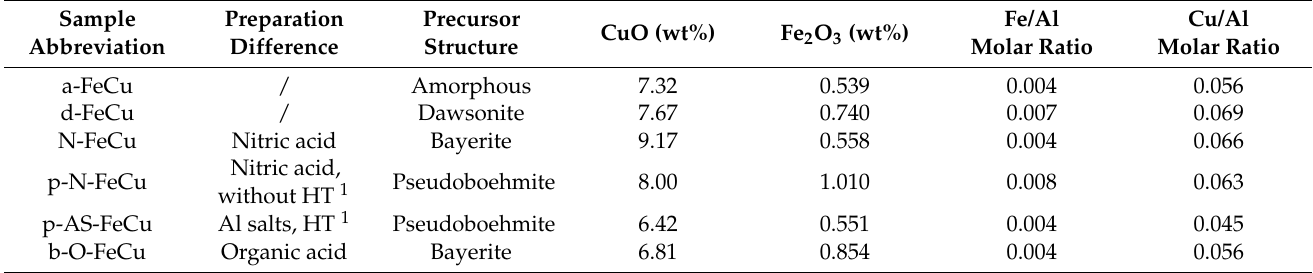
Table 3. Elemental analysis and presented Fe/Al and Cu/Al molar ratio of bayerite ( α -Al[OH] 3 ), pseudoboehmite (AlO[OH]), amorphous alumina and sodium dawsonite (NaAlCO 3 [OH] w ) derived